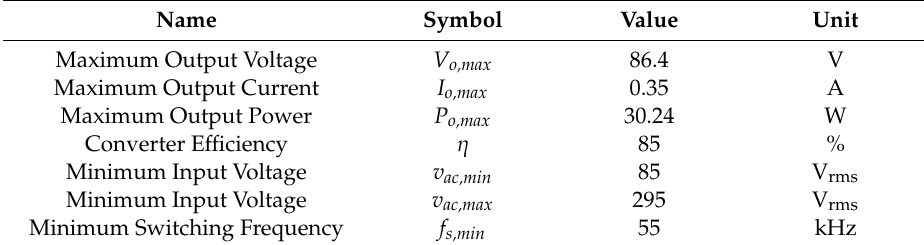
Table 2. Design parameters